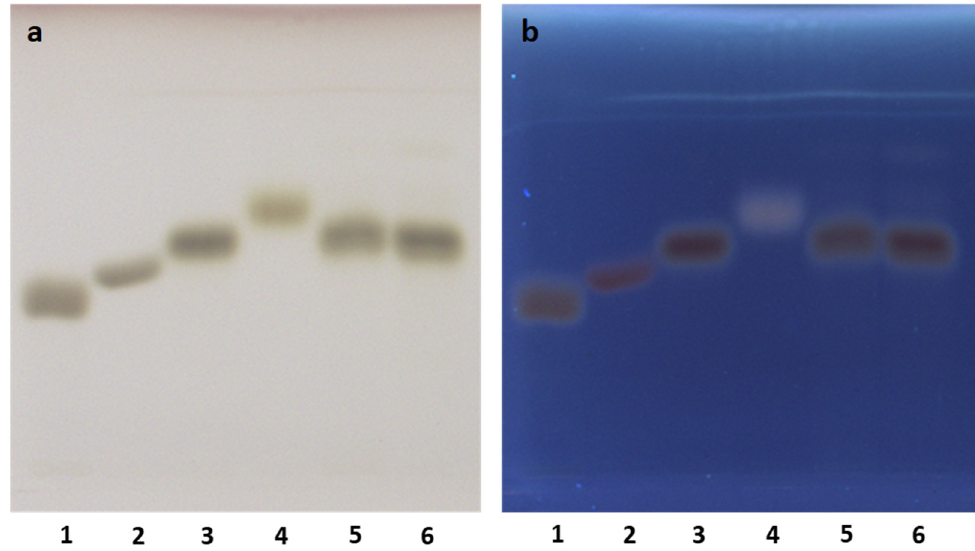
Figure 1. HPTLC analysis of the hydrolysate of the water-soluble polysaccharides from A. ramosus roots. Mobile phase: acetonitrile:water (85:15 v/v ). ( a ) Visualization, WRT light, derivatization with a solution of sulfuric acid in methanol. ( b ) Visualization, UV 366 nm, derivatization with a solution of sulfuric acid in methanol. Tracks: 1. galactose (1 mg/mL; 8 µ L); 2. glucose (1 mg/mL; 8 µ L); 3 fructose (1 mg/mL; 8 µ L); 4. arabinose (1 mg/mL; 8 µ L); 5. hydrolyzed AR2 (1 mg/mL; 8 µ L); 6. hydrolyzed inulin (1 mg/mL; 8 µ